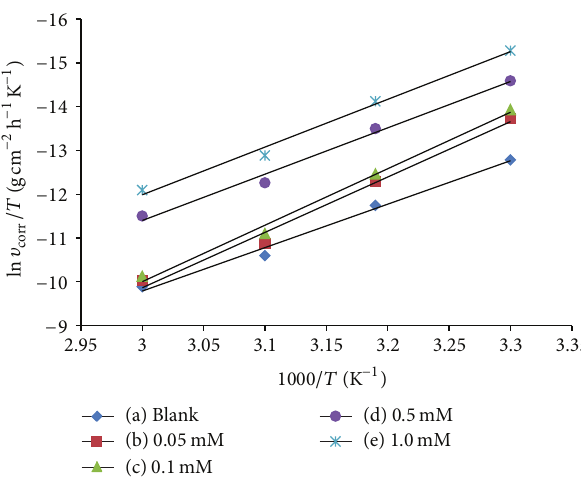
Figure 6: Transition state plot for mild steel in 1M HCl solution with RS at different concentrations.